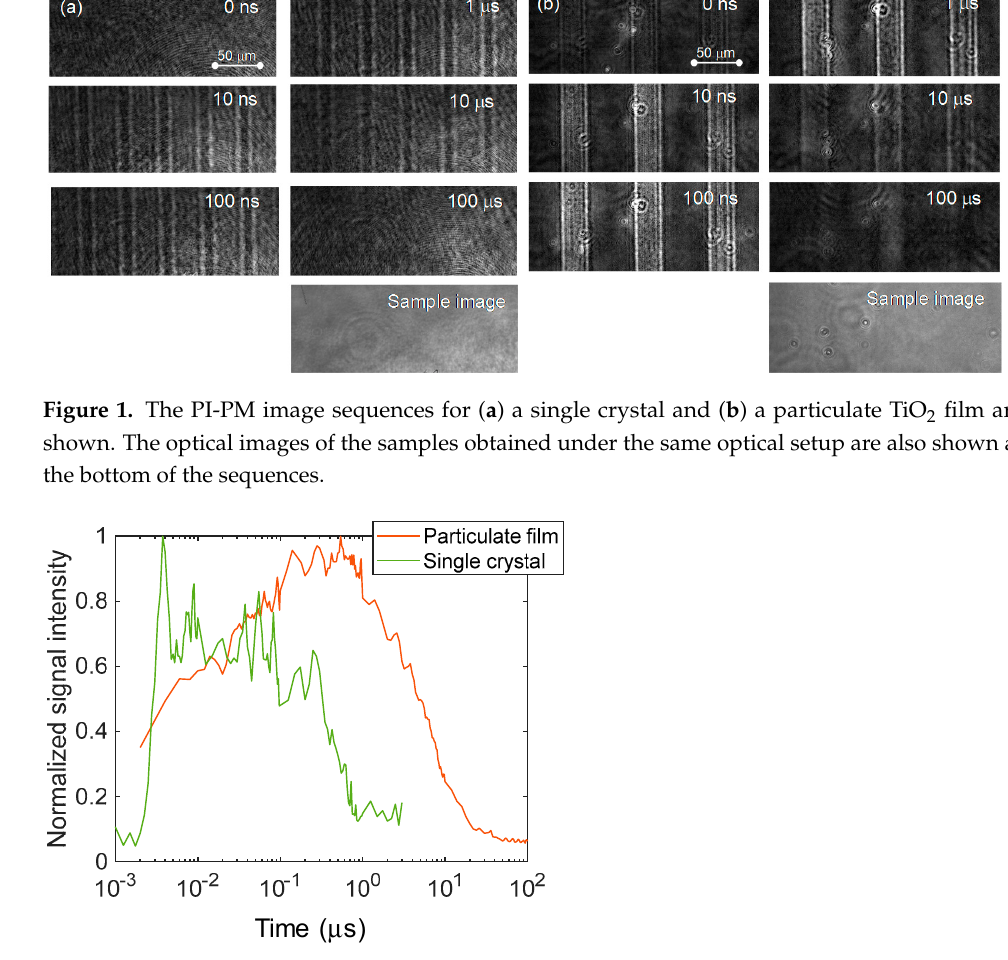
Figure 2. The normalized temporal responses of the refractive index changes for the particulate film and the single crystal of TiO 2 are shown. The signal amplitude was calculated from the images of Figure 1.